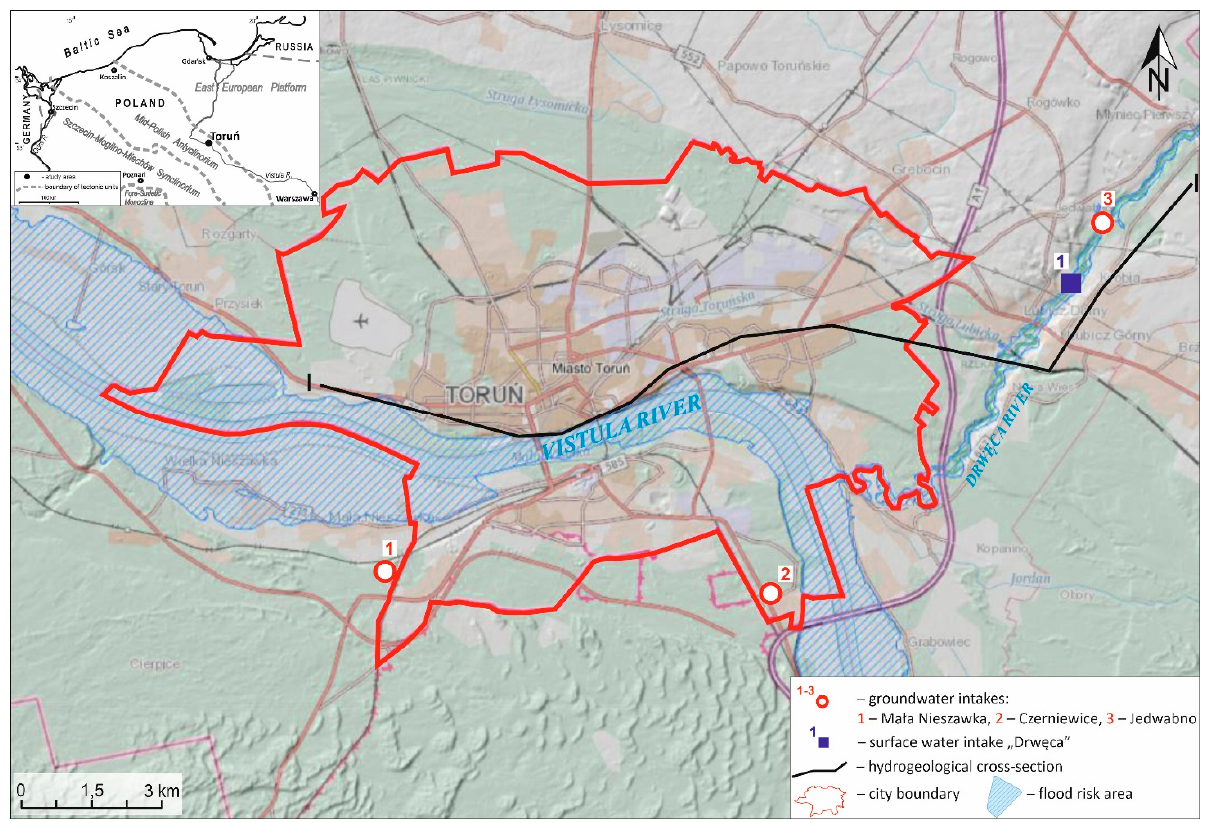
Figure 1. Research area.